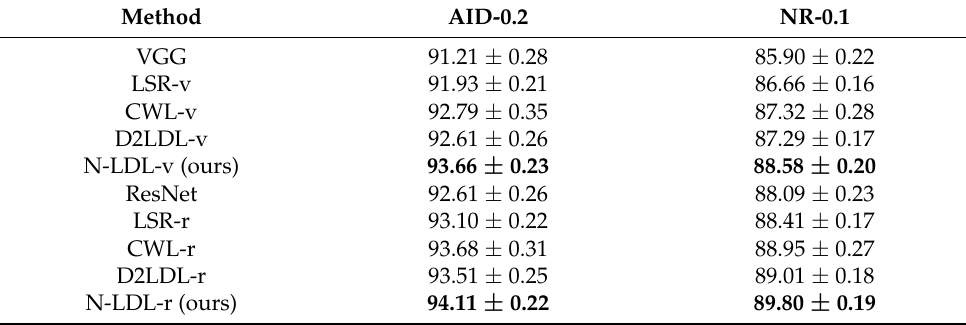
Table 3. OA (%) comparisons using various label